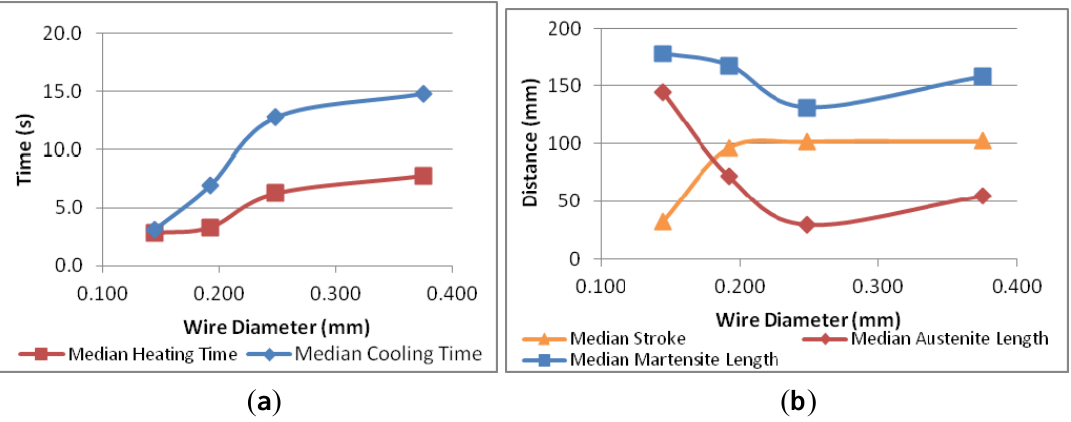
Figure 4. Experimental results from the wire diameter manipulation. ( a ) (Left) The averaged median heat and cooling times. ( b ) (Right) The averaged median strokes, martensite lengths and austenite